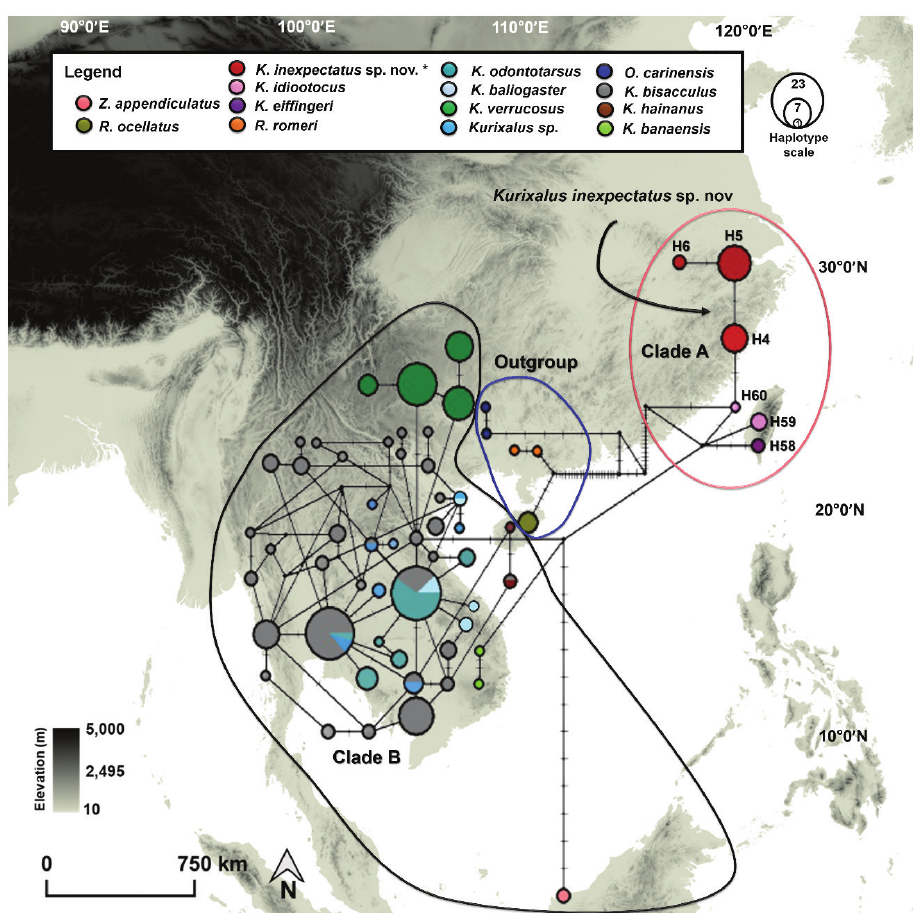
Figure 5. Haplotype network inferred from 216 phased nuDNA TYR sequences data (486 sites). The haplotype group for the focal Clade A comprised six representative haplotypes of Kurixalus . Clade A included three K. inexpectatus sp. nov. haplotypes. The size of each haplotype marker matches the haplo- type scales. The colour coding matches with the name of the taxa in the legend. The colours used for the boundaries of Clade A and Clade B are coded similarly to the colours of their clades in the phylogenetic tree (Suppl. material 1: Fig.